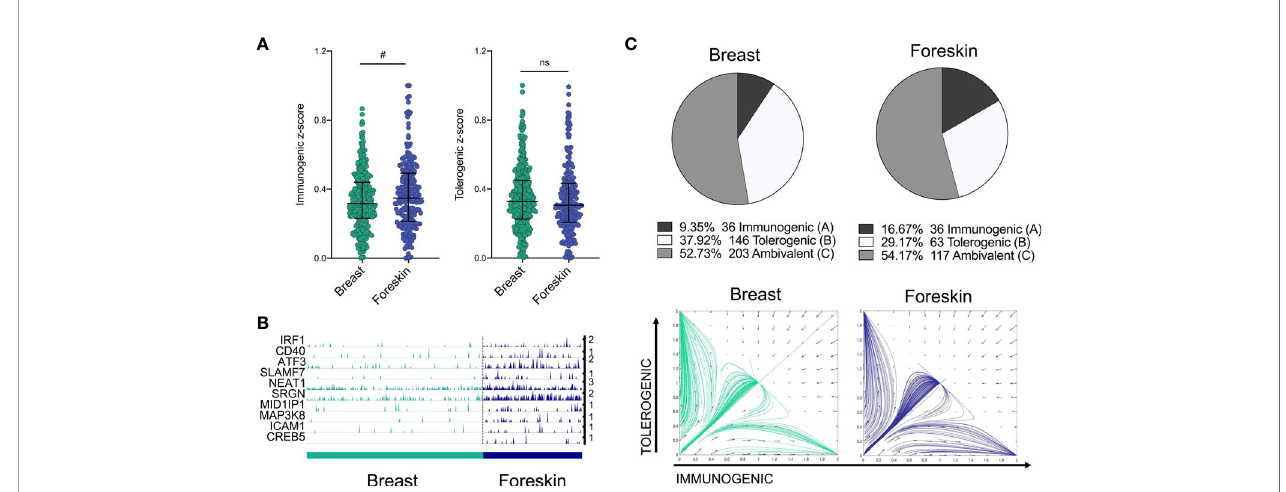
FIGURE 4 | IRF1/IRF4 toggle-switch determines body-site speci fi c differences in LC immunogenic programming. (A) Immunogenic and tolerogenic z-score values are displayed for.breast derived skin and foreskin LCs. Mann-Whitney test, # p<0.1, ns, not signi fi cant. (B) Trackplots comparing the expression of transcripts associated with immunogenic LC function across breast skin derived and foreskin LCs. (C) Pie charts summarising the numbers and percentages of LC assigned to each phenotype through utilising the toggle-switch model for trajectory plotting. For each trajectory, representing an individual breast-derived or foreskin-derived LC, the x-axis represents z-scores combining normalised IRF1/IRF4 expression values; the y-axis represents the z-scores combining SOX4, KRAS, IRF4, RELB and ELK1 expression values. Z-scores were scaled to fi t phase portrait